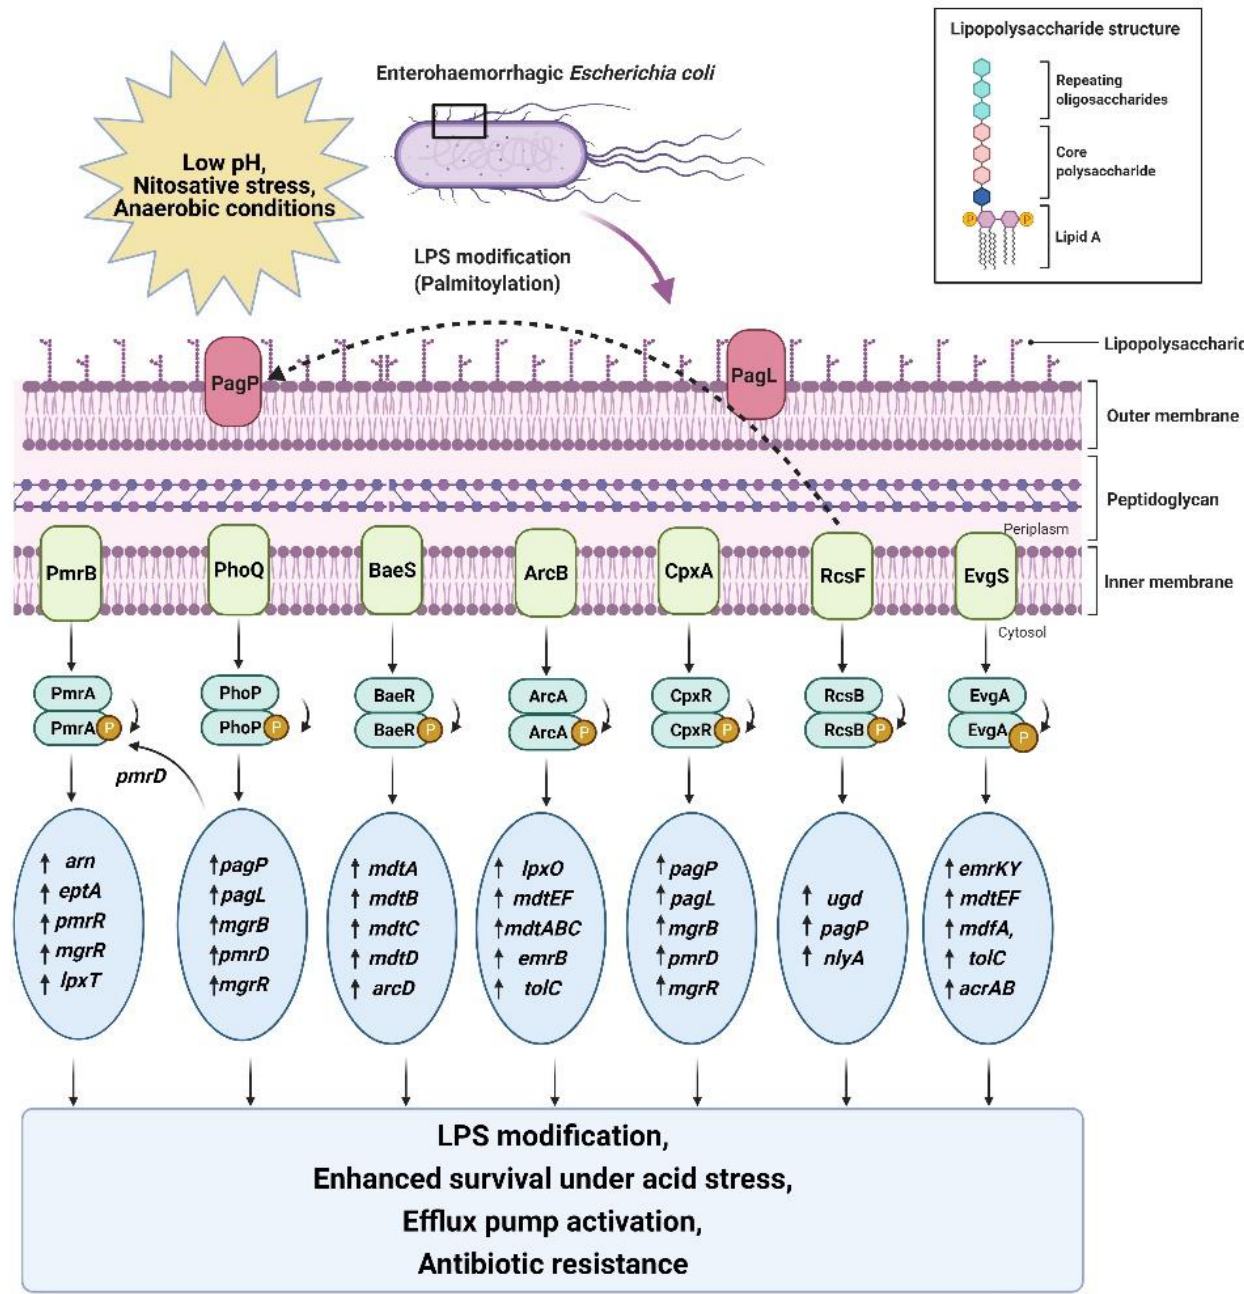
Figure 3. Schematic representation of the acid-induced activation of a specific set of genes by two-component systems leading to LPS modification, efflux pump activation, enhanced survival, and antibiotic resistance in EHECs. All abbreviations are defined at the end of the manuscript.